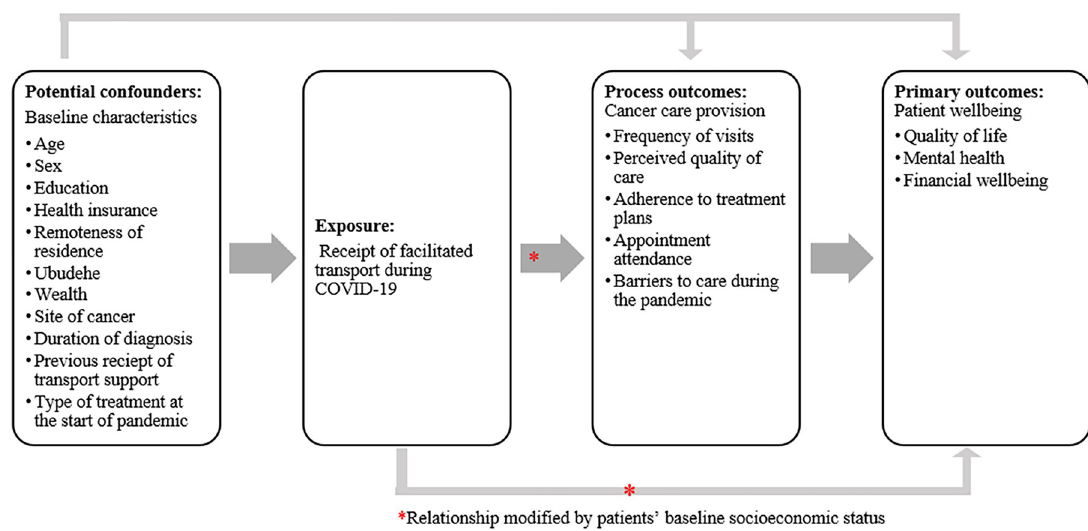
Fig 2. Conceptual framework describing the relationship between patient characteristics, receipt of facilitated transport, cancer care provision, and patient wellbeing.